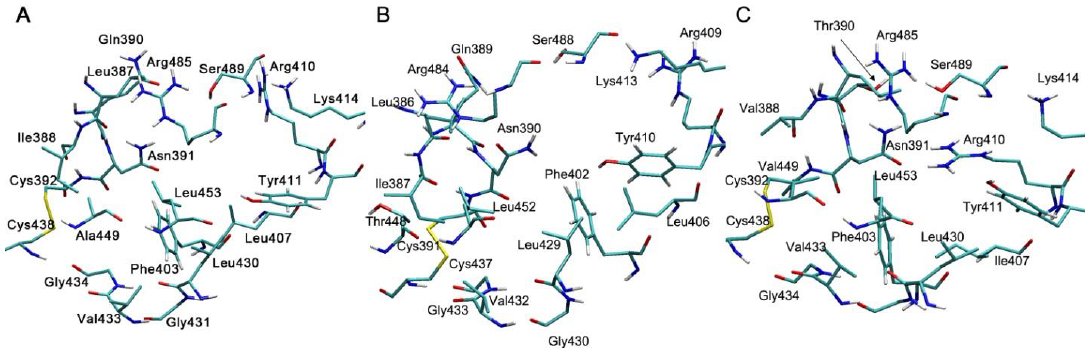
Figure 4. The structures of Sudlow site II of human ( A ), bovine ( B ) and rat ( C ) albumin.